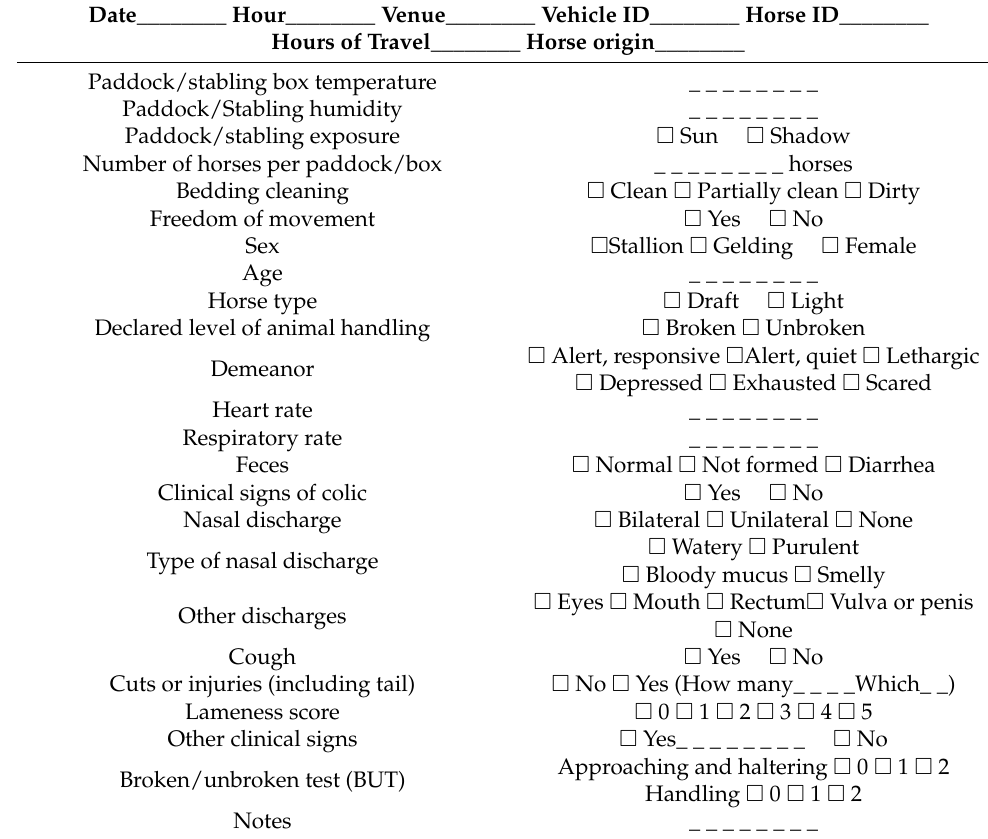
Table 4. Checklist used 24 h after unloading to evaluate the welfare status of the individual horses that arrived in a Southern Italy